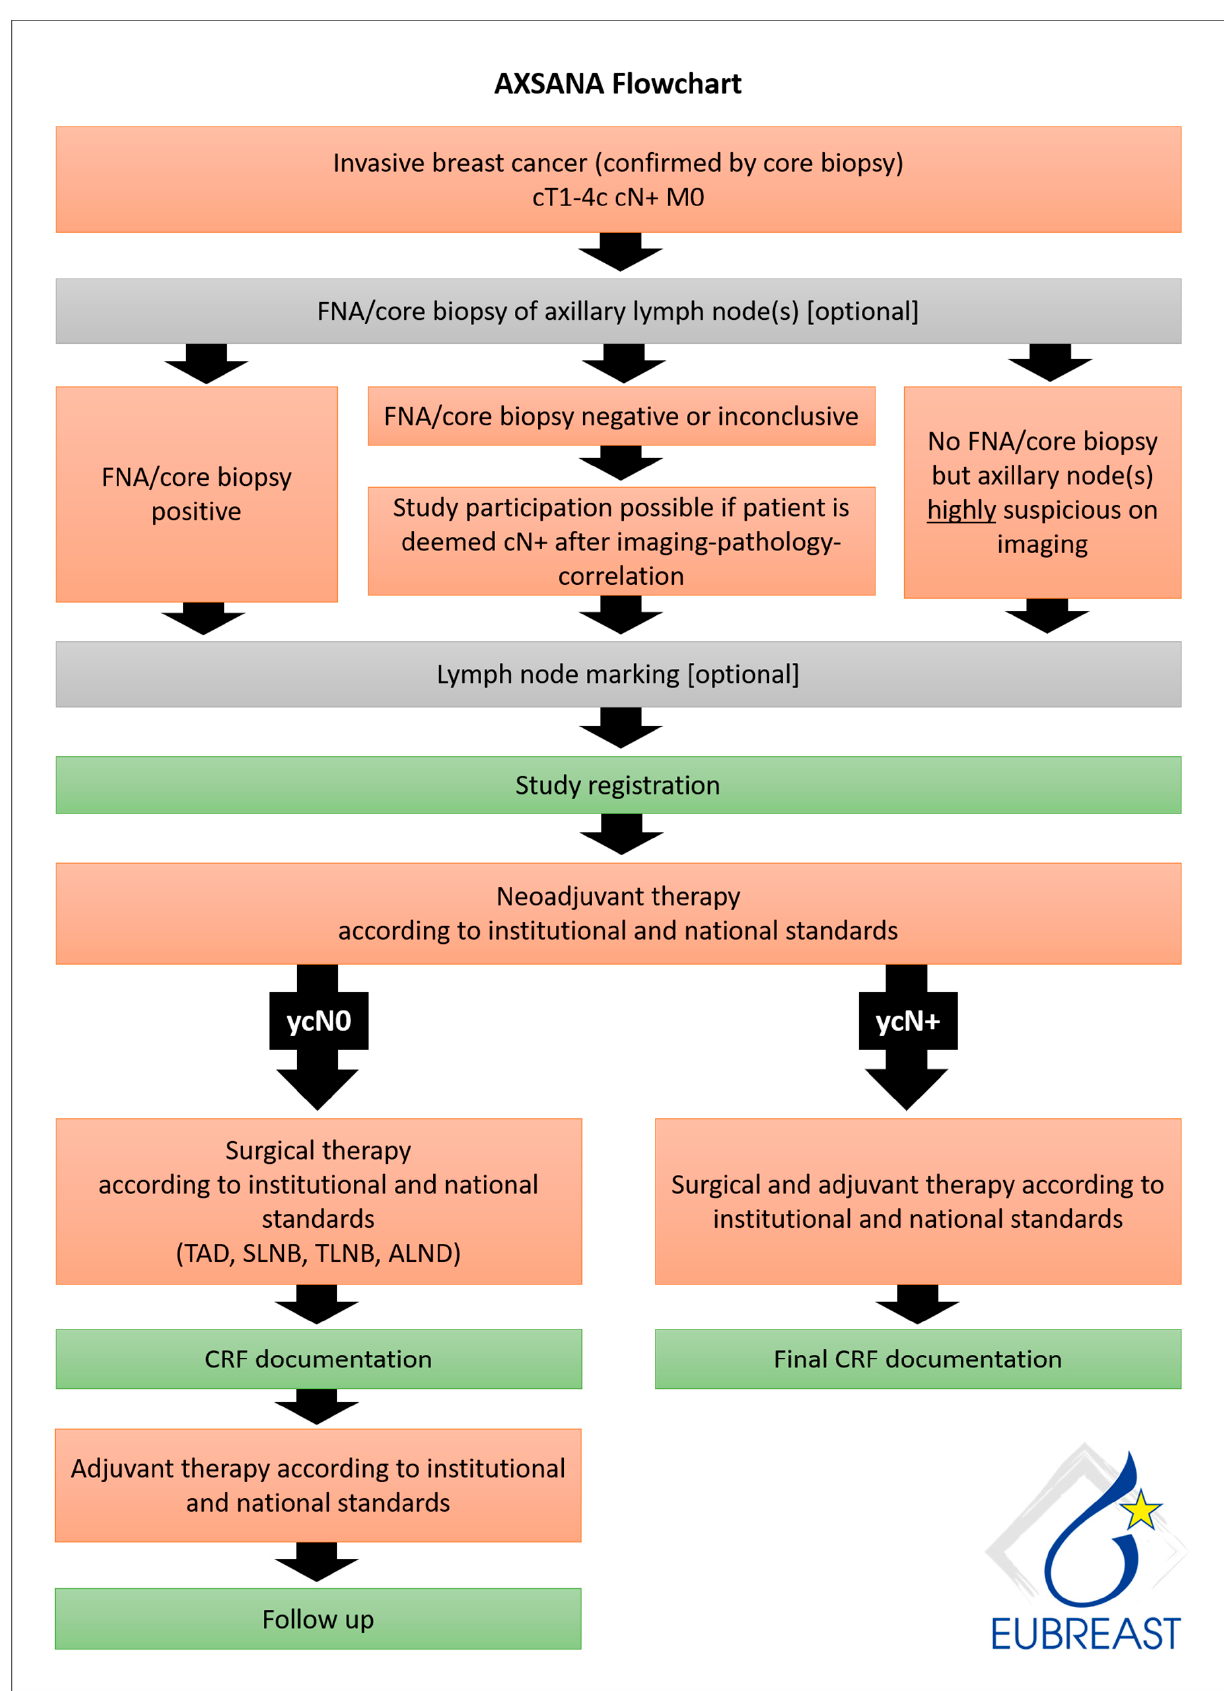
Figure 1. AXSANA flow